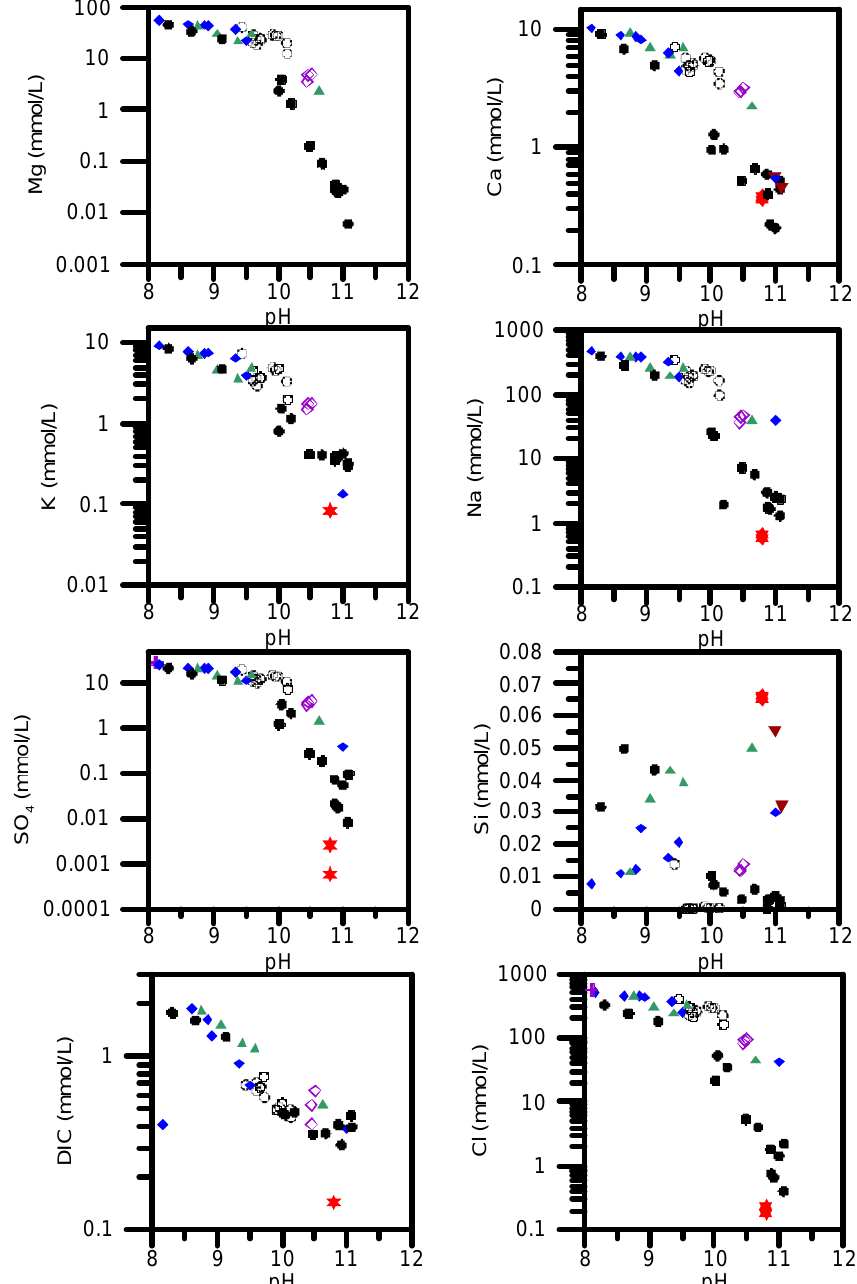
Figure 6. Element concentrations of the collected water samples versus pH. Same symbols as for Fig. 5.